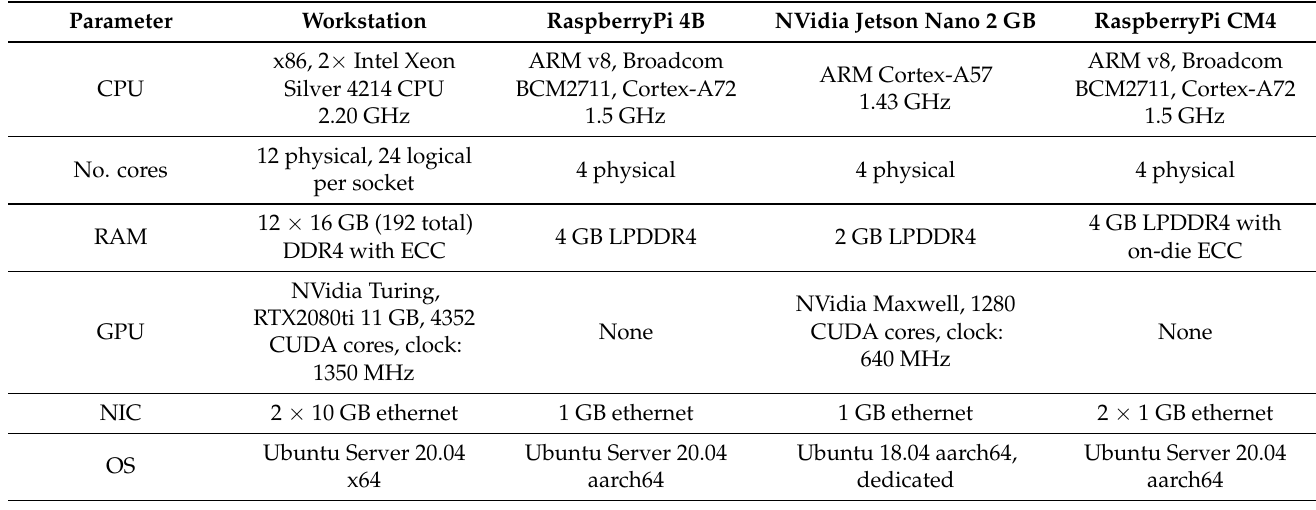
Table 1. Parameters of the hardware used in proposed edge system